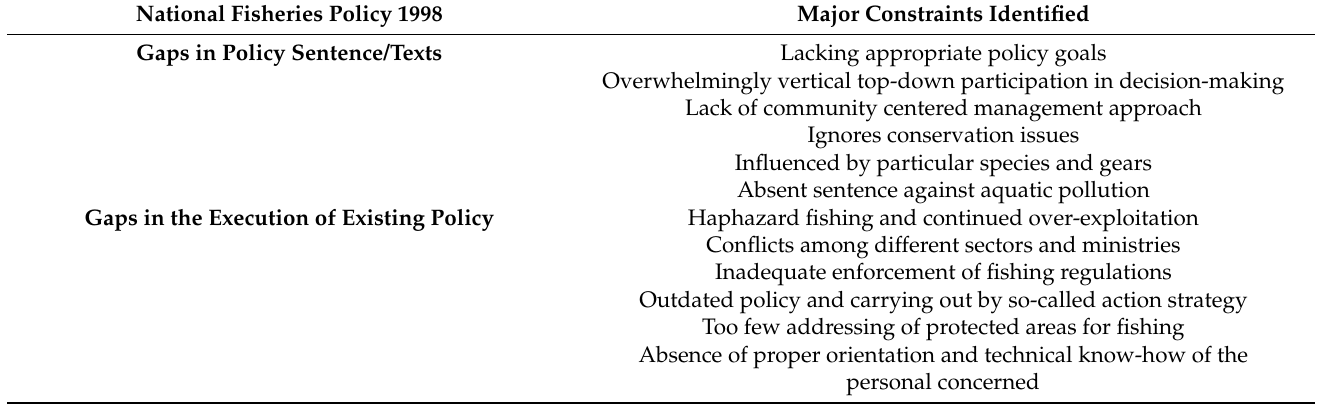
Table 4. Identified constraints of the national fisheries policy